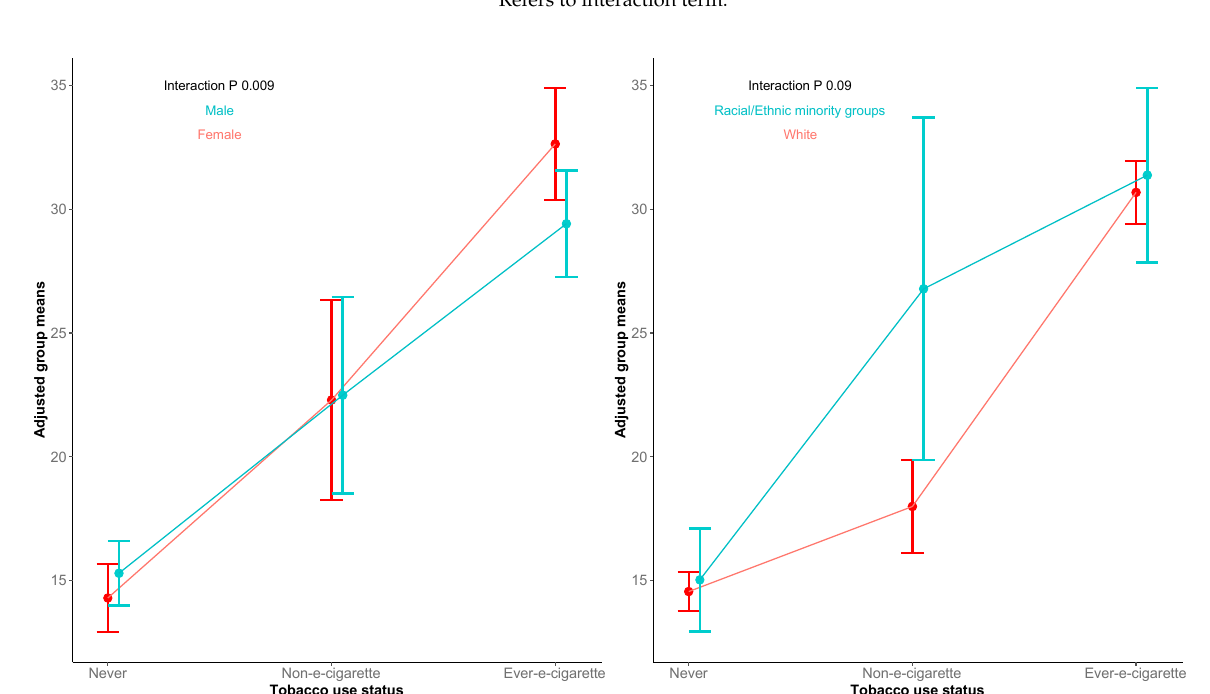
Figure 1. Average Marginal Effects of Two-Way Interactions between Tobacco Use Status and Gender and Between Tobacco Use Status and Race/Ethnicity.